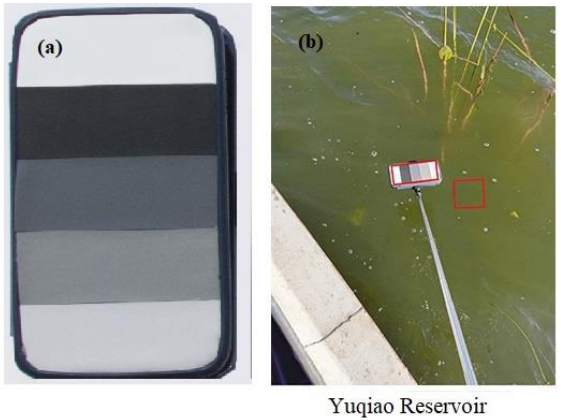
Figure 3. ( a ) The five-color reference card used in this study. ( b ) Sample image of five-color reference card and water taken using a smartphone with automatic exposure parameters. The red box indicates the position of the uniform area clipped. Table 3. Reflectance parameters of each band of the five-color reference card. Band Red Band Green ReflectanceScale